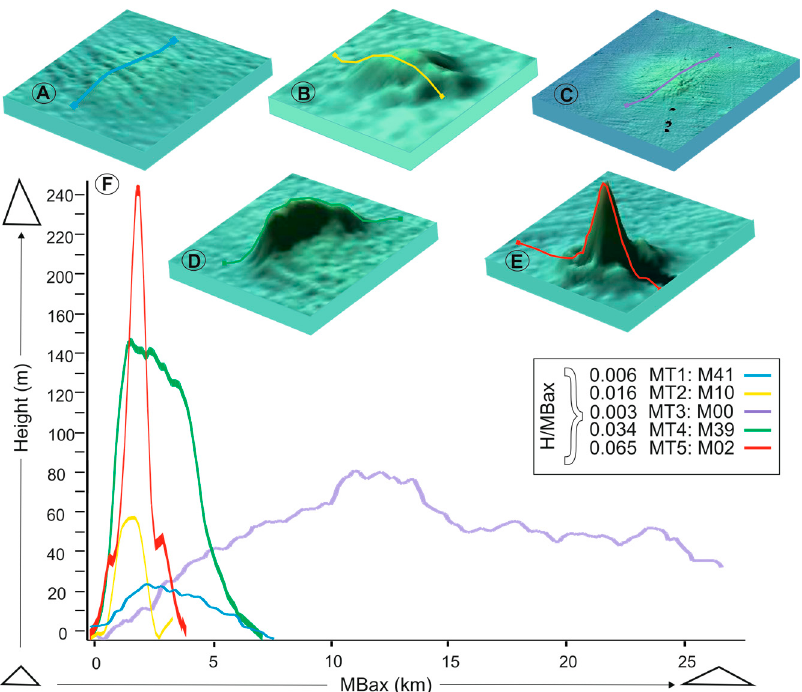
Figure 6. Representative geometry and bathymetric profiles for each type of edifice illustrating the variation in profile shapes. ( A ) M41 (MT1); ( B ) M10 (MT2); ( C ) M00 (MT3); ( D ) M39 (MT4); ( E ) M02 (MT5) and ( F ) Bathymetric profiles of five types of morphometries. The mean aspect H/MBax ratio of each MT indicates that domes are considerably lower than volcanoes.